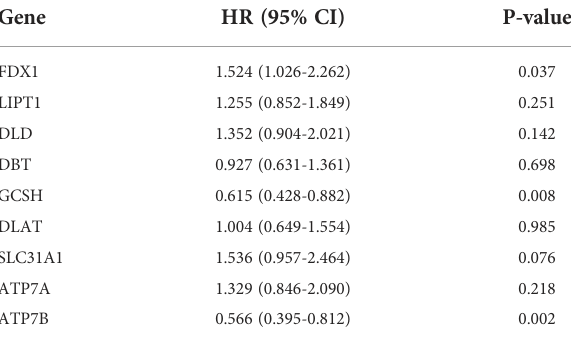
Table 1. Multivariate Cox regression analysis of 10 cuproptosis- related genes associated with overall survival in lower-grade glioma